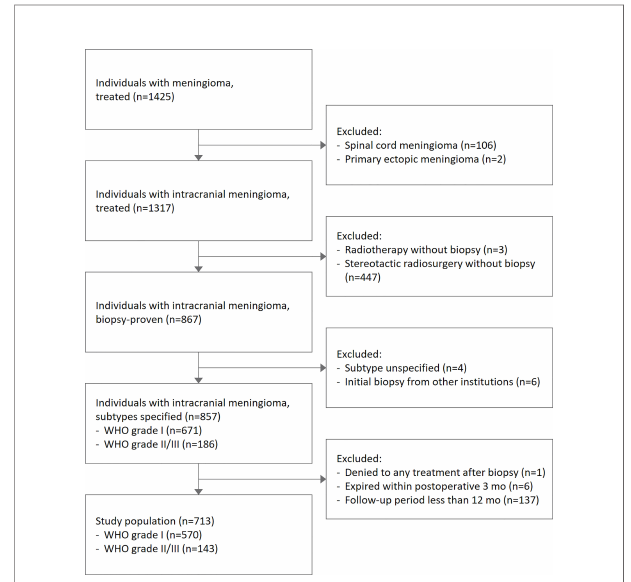
FIGURE 1 | Selection of study